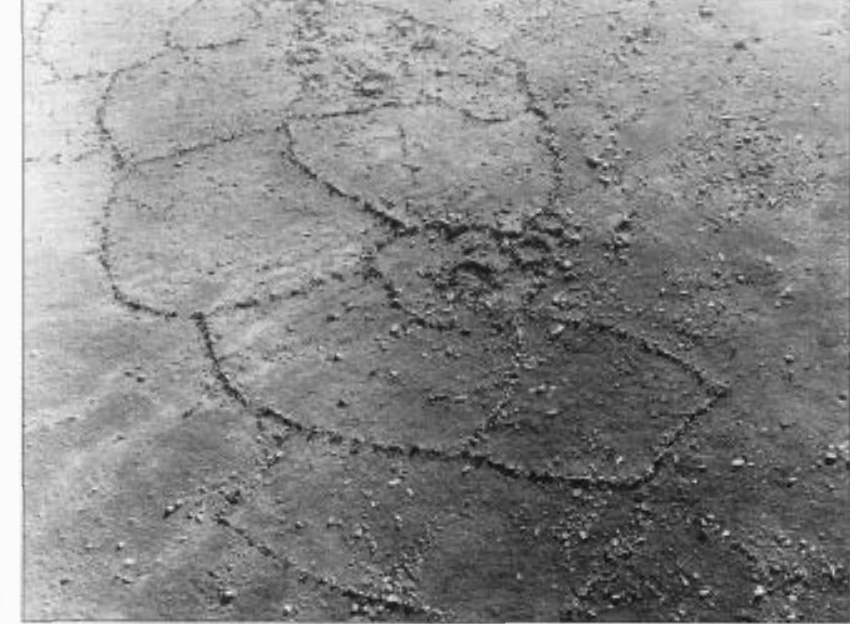
Figure 1 Oblique aerial photograph of part of the southern settlement and enclosures at Leskernick; view northeast, February 1979.